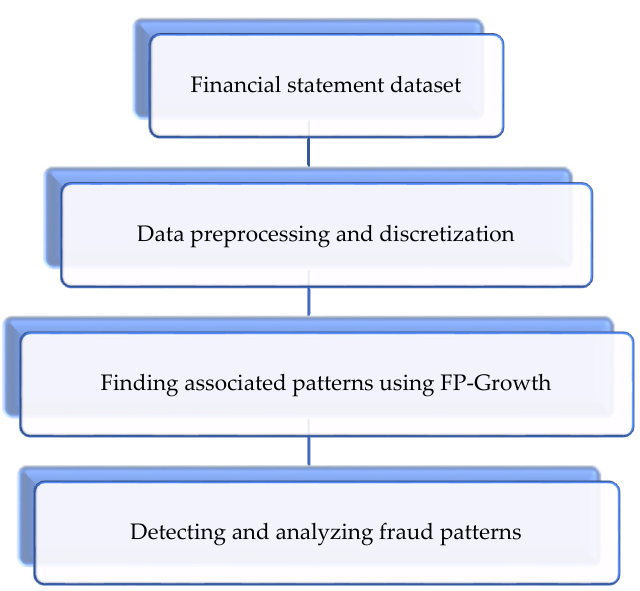
Figure 2. The proposed method for analyzing and detecting fraud patterns.